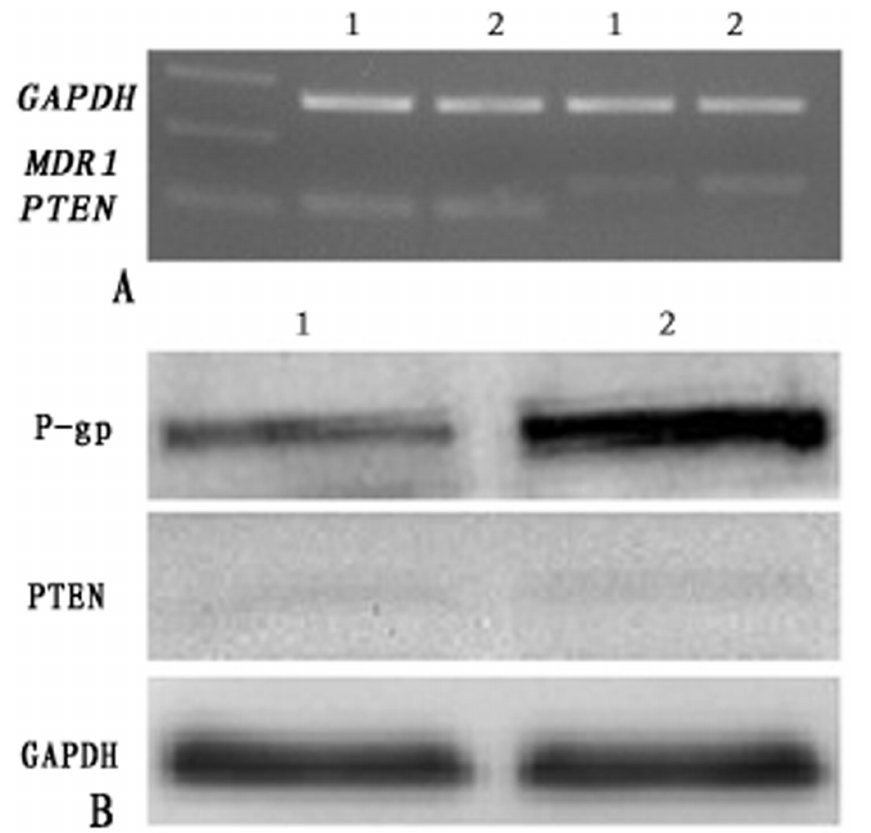
Fig 3. Expression of MDR1 、 PTEN mRNA and Protein in A2780 and A2780/DDP cells. (A) MDR1 and PTEN mRNA levels in A2780 and A2780/DDP cells. The expression of MDR1 mRNA was overexpressed in A2780/DDP compared with A2780(P < 0.05), and the PTEN mRNA level showed no difference(P > 0.05). (B) P-gp and PTEN protein expression levels in A2780s and A2780/DDP cells. The expression of P-gp in A2780/ DDP cells was higher than that of A2780(P < 0.05),and PTEN protein was at a very low levels in A2780 and A2780/DDP cells. (1,2:A2780,